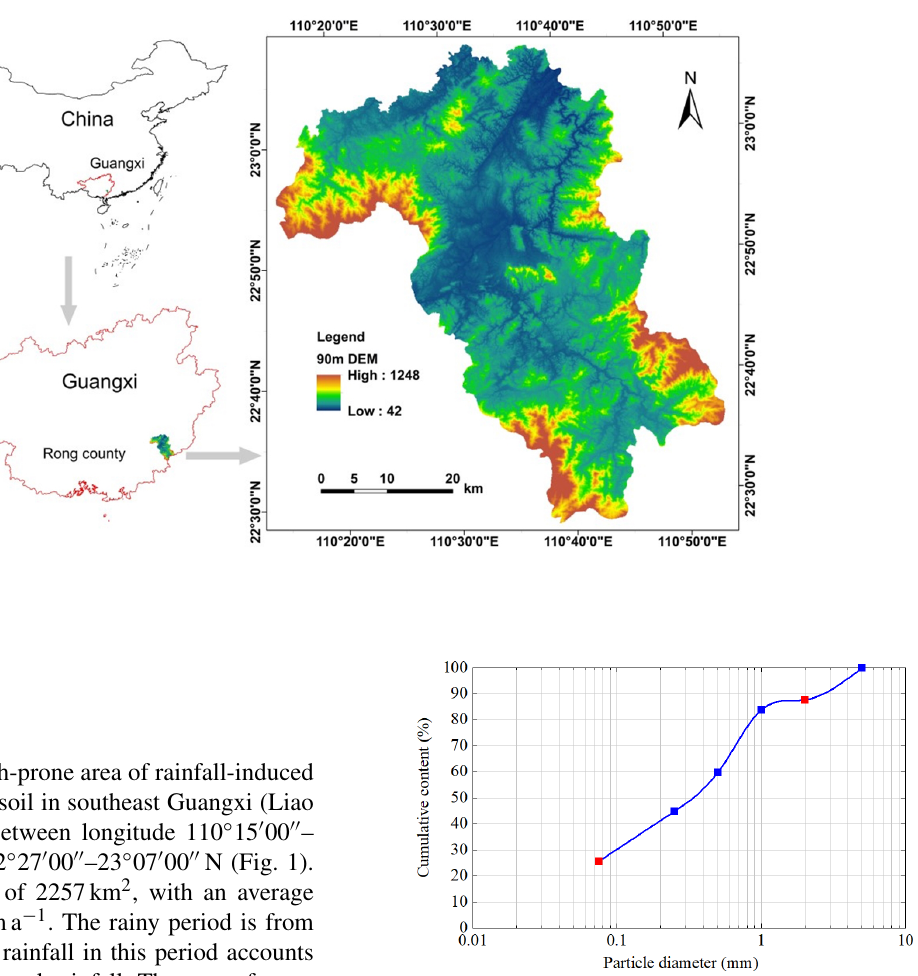
Figure 2. Particle gradation of granite residual